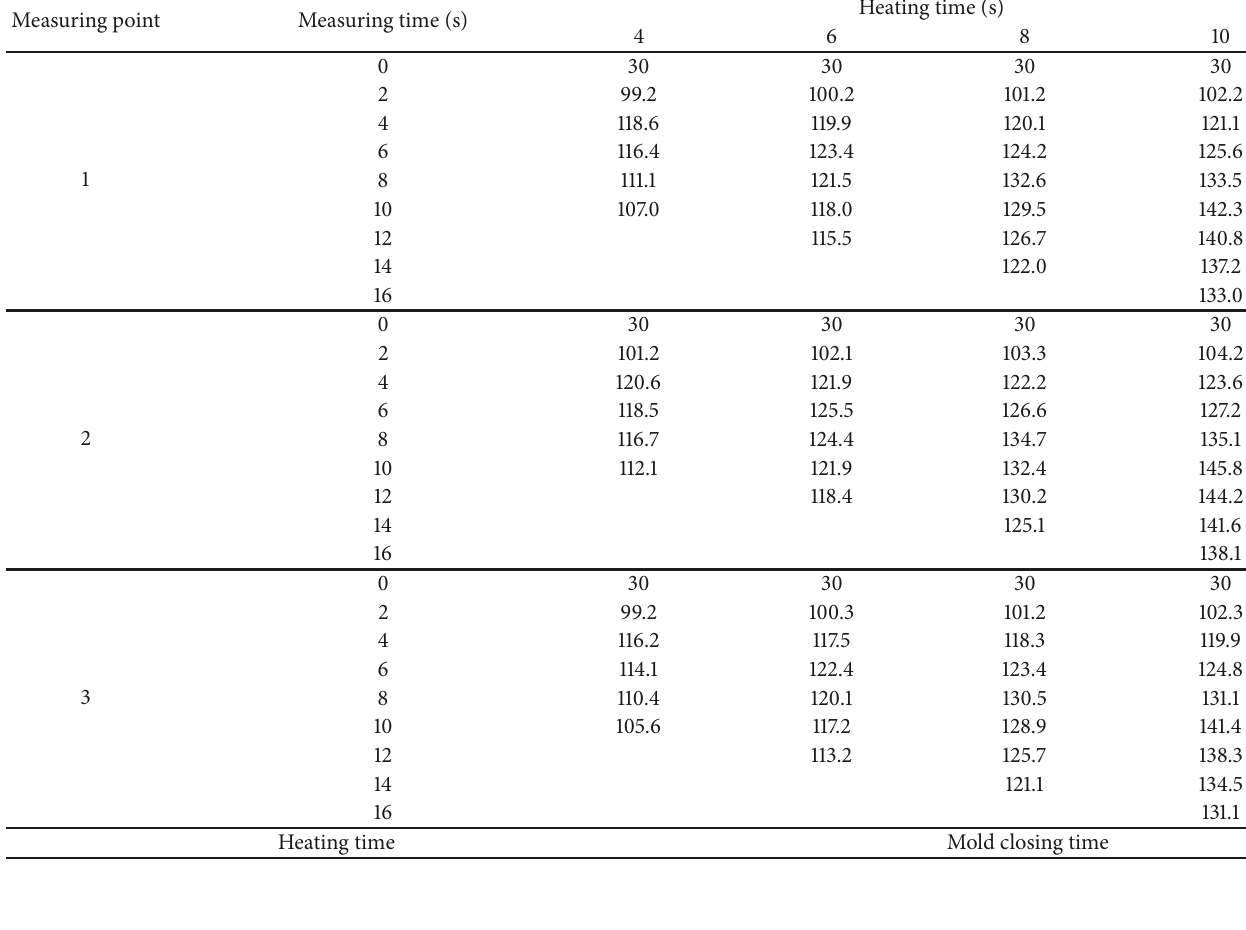
Table 4: Experimental results for cavity temperature with the thin rib mold at different heating times. Measuring point